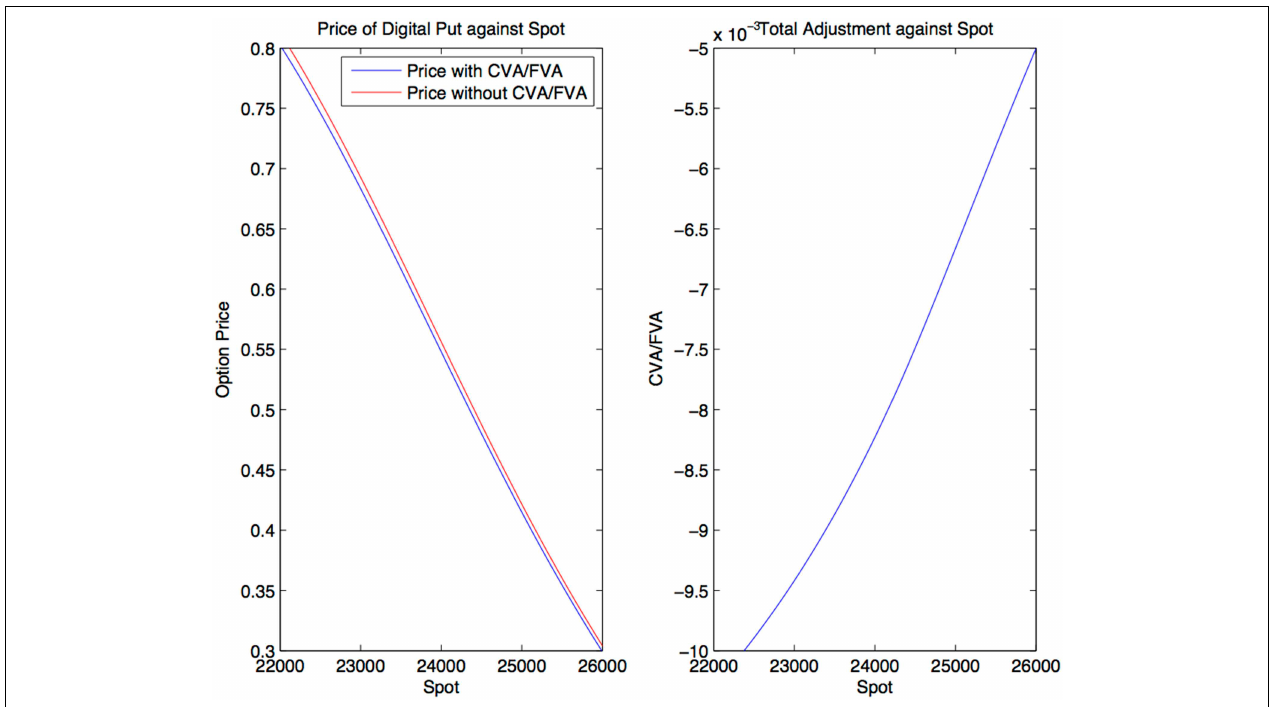
FIGURE 3 | Prices of digital put under KoBoL process as of 9 January 2015, time to maturity T = 0 . 463 , spot, strike S = K = 24 , 000 , risk-free rate r = 0 . 52 % , collateral rate r C = 1 % , funding rate r F = 1 . 7 % default intensity λ = 0 . 05 , recovery rate R B = 0 . 4 , collateral threshold H B = 0 . 5 .